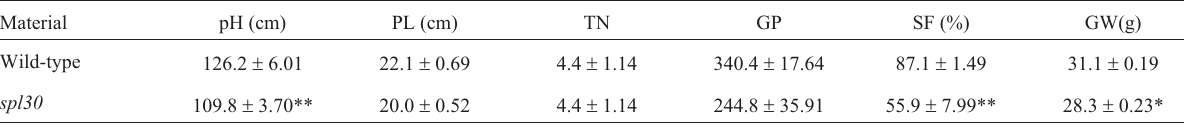
GP = grains per panicle, GW = weight of 1000 grains, pH = plant height, PL = panicle length, SF = setting fertility, TN = tiller number per panicle. The values are the mean (cid:3) SD of 10 plant determinations. * , **p < 0.05 and p < 0.01, respectively, compared to wild-type plants.